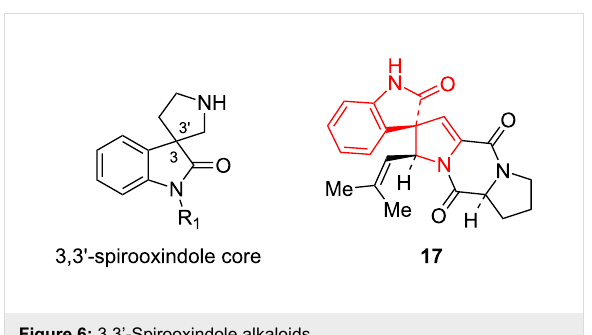
Figure 6: 3,3’-Spirooxindole